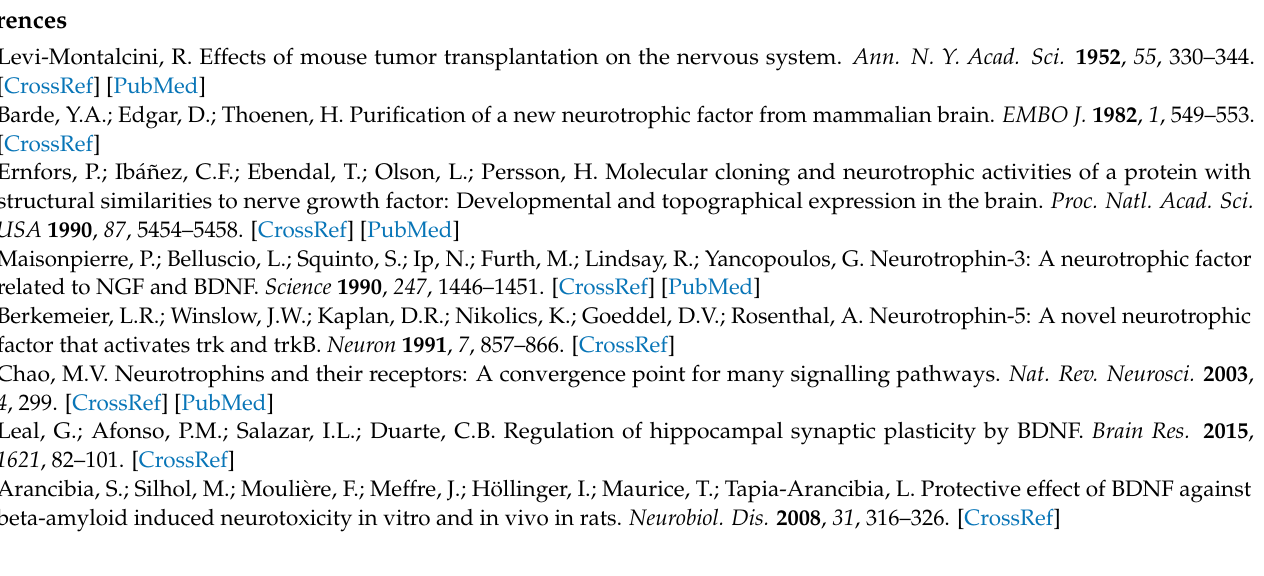
Figure S7: Effects of ACD855 on neurotransmitters in the ventral hippocampus as judged by micro- dialysis., Figure S8: Effects of ACD855 in the Morris water maze, Figure S9: Effects of ACD855 on latency activity or exploration in naïve animals using the passive avoidance task, Figure S10: Effects of ACD856 on acquisition, consolidation or retrieval on scopolamine-induced amnesia in the passive avoidance model as measured by retention